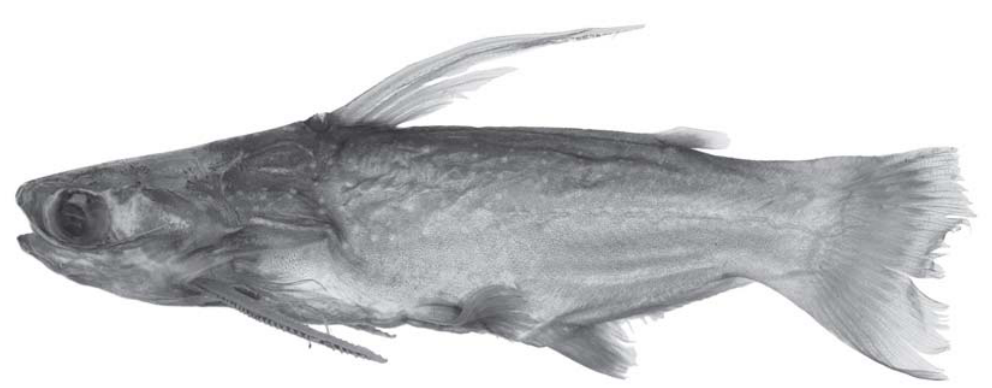
Fig. 4. Auchenipterichthys coracoideus , AMNH 12700, 100 mm SL, nuptial male; Brazil, rio Livramento, tributary of rio Madeira (7°17’S, 62°22’W). Posterior rays of anal fin folded over, which gives an incorrect impression of the fin margin.